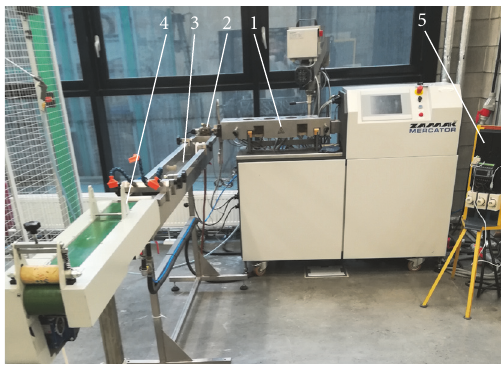
Figure 1: Test stand: 1, corotating twin-screw extruder; 2, extrusion head; 3, cooling tank; 4, belt puller; 5, electric energy